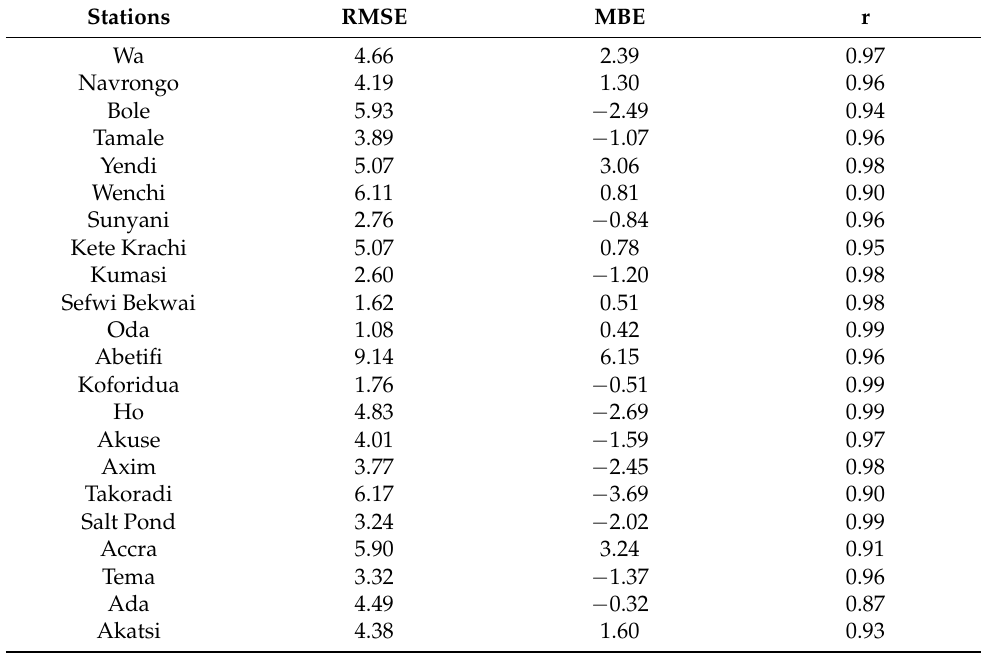
Table 2. Summary of statistical indices comparing estimated and observed total cloud cover for all stations in the four climate zones. Root mean square error (RMSE), mean bias error (MBE), and Pearson’s correlation coefficient (r).